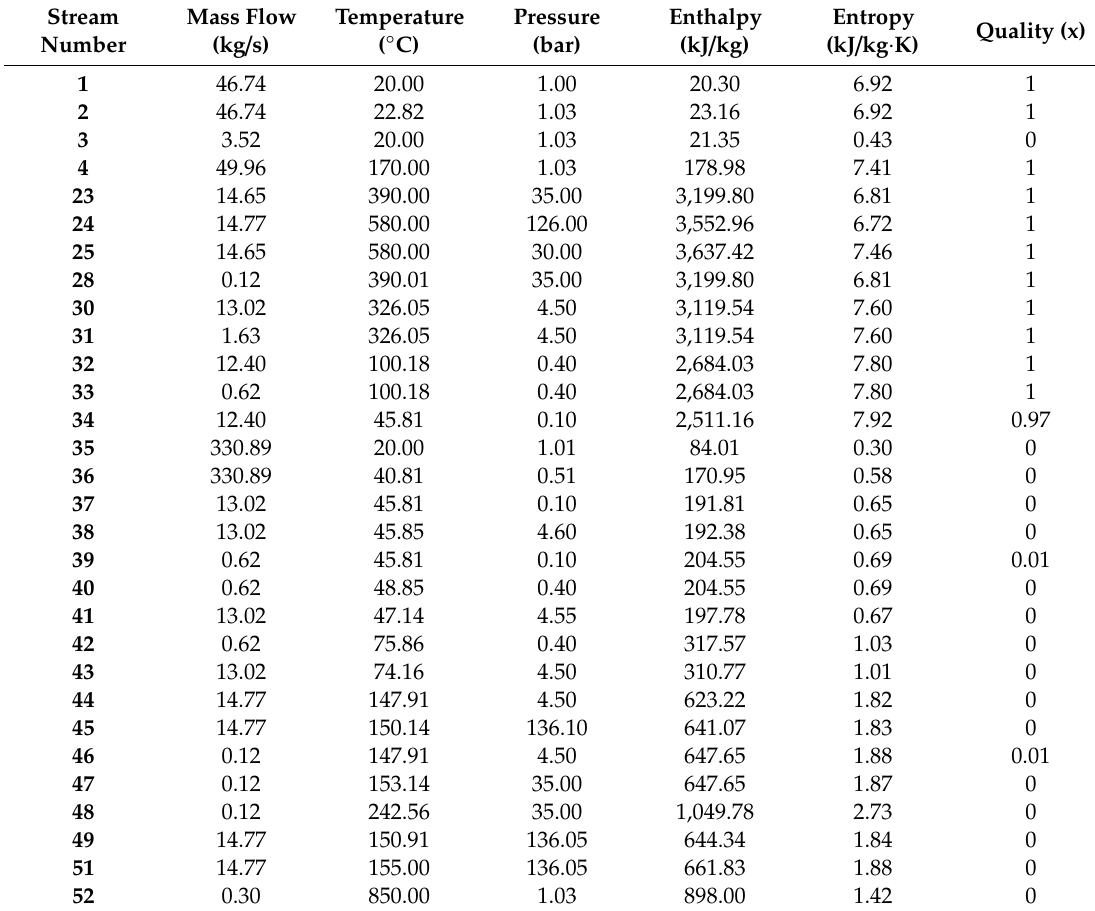
Table A2. Biomass stream